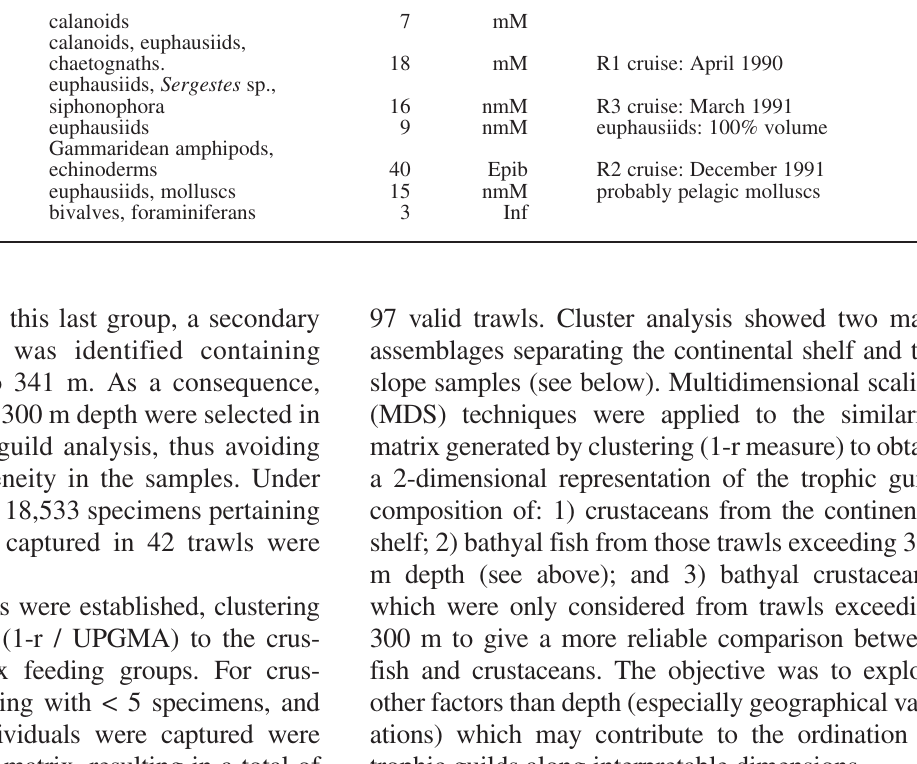
Table 2.- Diets of different decapod species dominant in the present survey. (n): number of individuals analyzed; TG: trophic guild assigned. (*) from MEDITS-99 cruise. Species prey items n TG Gennadas